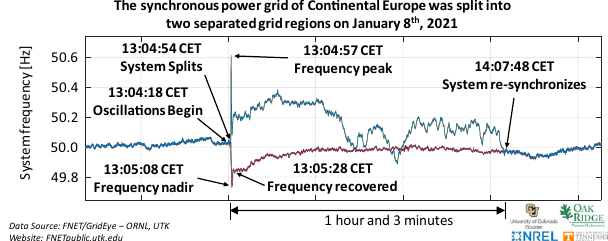
Fig. 1 Frequency traces of the European synchronized continental power network recorded by Phasor Measurement Units across this network on January 8, 2021. In this plot, two distinct frequencies are visible after a loss of synchronization when the network was split into two sub-networks with an interruption in power delivery for a duration of 1 h and